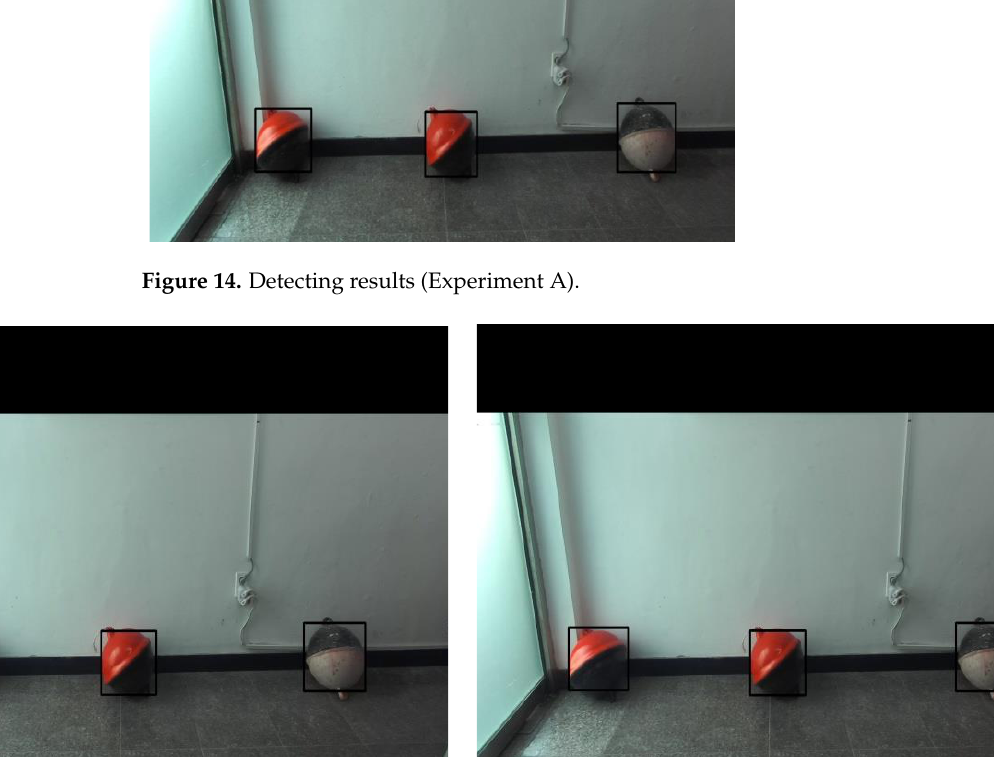
Figure 15. Area-based stereo matching results (Experiment A): ( a ) SSD and ( b ) NCC.